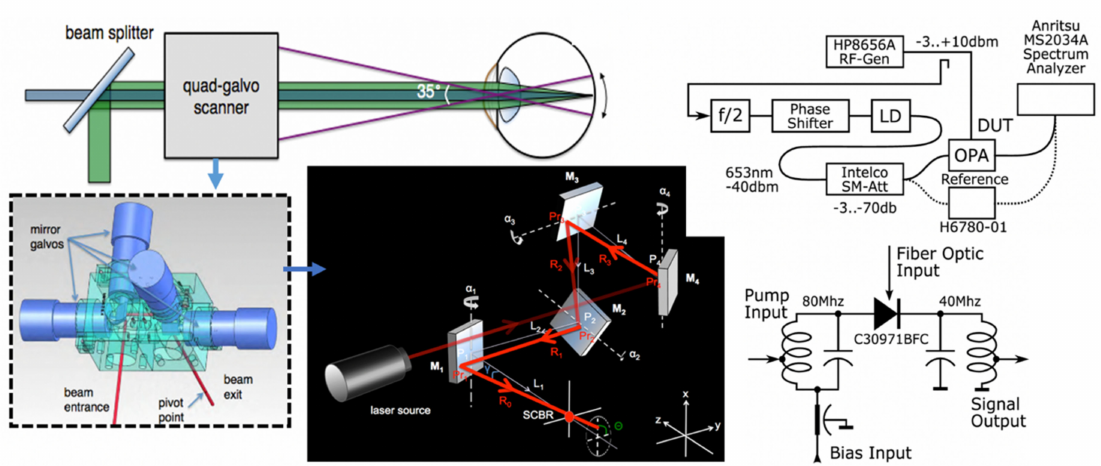
Figure 22. New multimode confocal scanning laser ophthalmoscope. The system is based on a supercontinuum laser light source with spectral options (not shown), quad-galvo scanning ( left ) [161], and degenerate optical parametric amplification- based low light detection ( right )